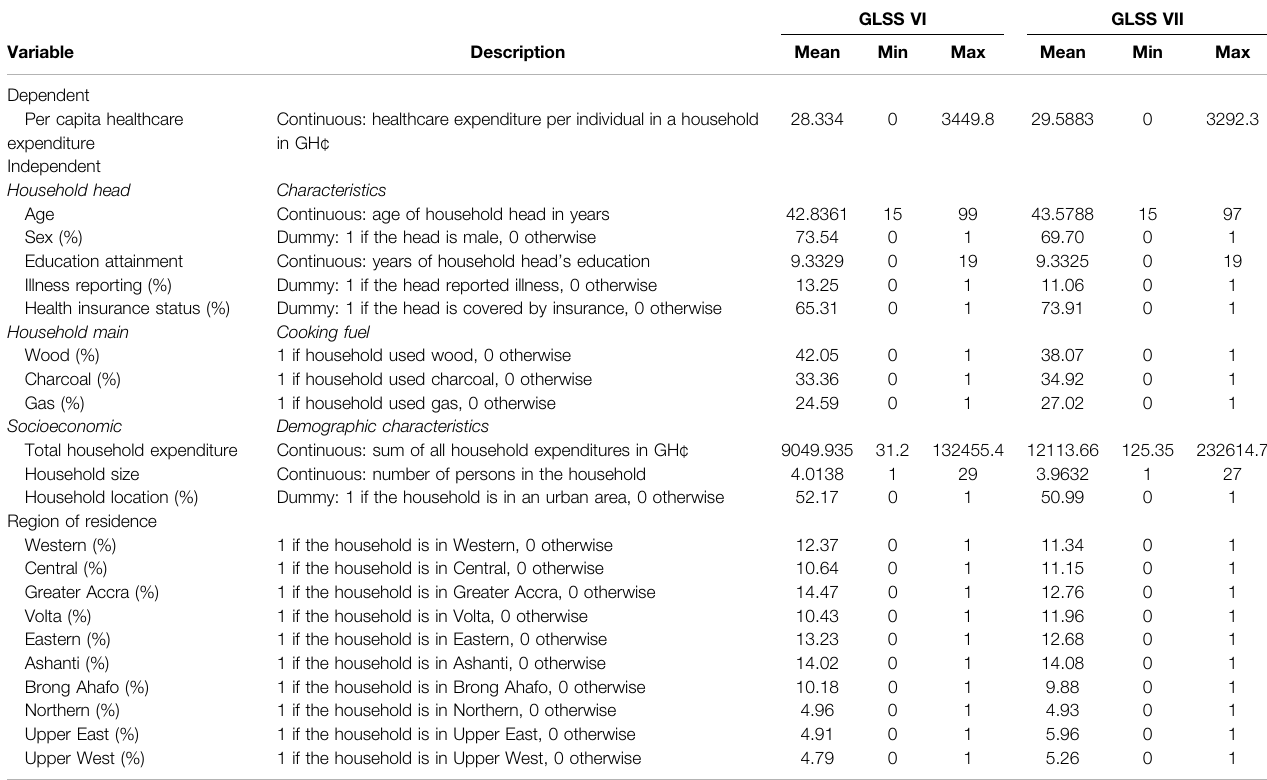
TABLE 1 | Variable description and summary